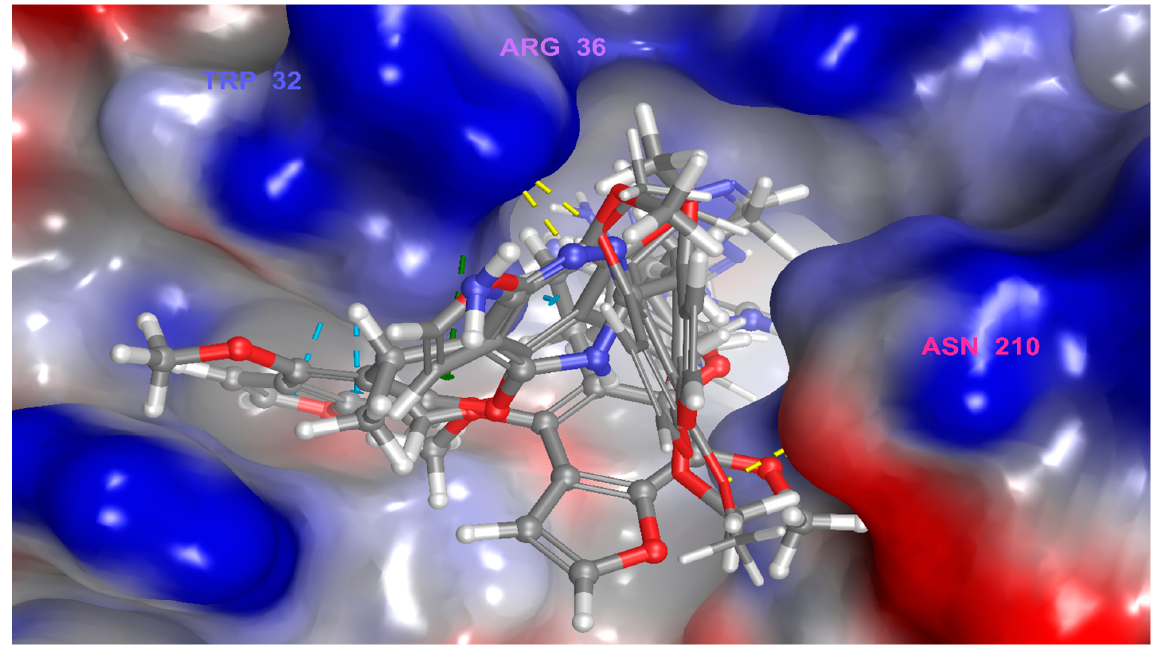
Figure 4. The best docked molecules are superimposed on the active site region of 1HNJ protein and active residues are visualized using Maestro.